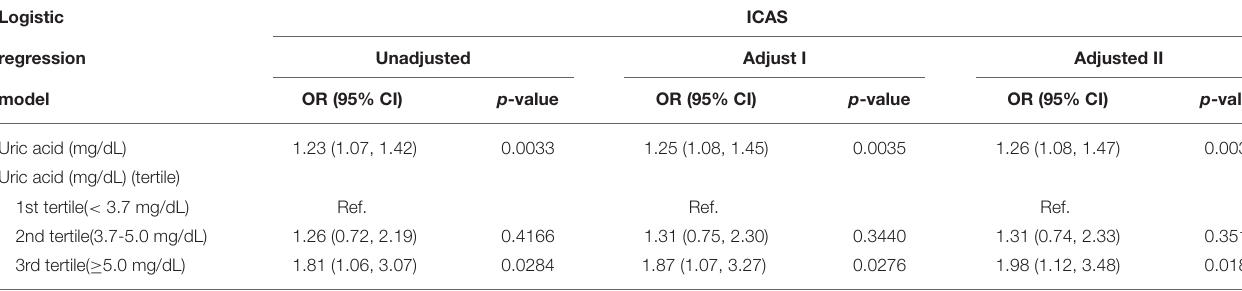
TABLE 3 | Multivariable logistic regression analysis of uric acid in the presence of ICAS. Logistic